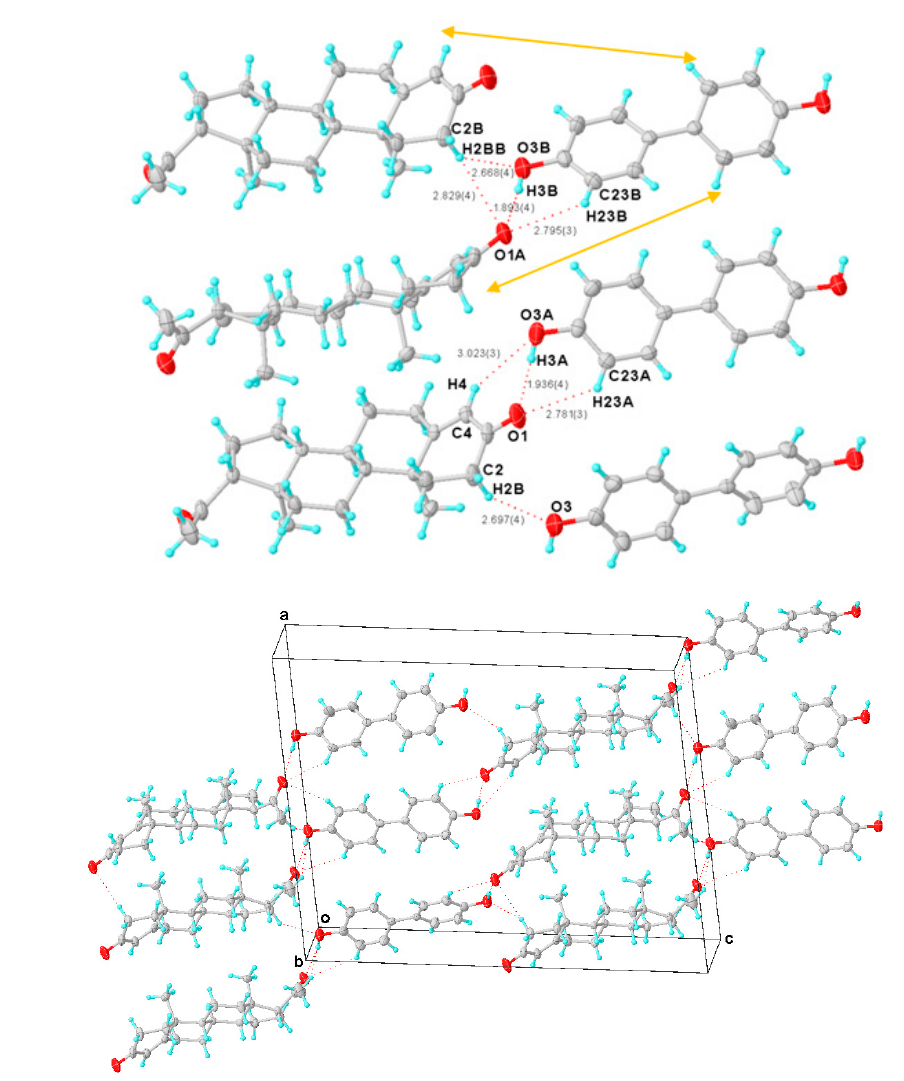
Figure 4. ( a ) Asymmetric unit of PROG-DOD. ( b ) Three-dimensional structure of PROG-DOD. The ellipsoids are drawn with 30% probability and all hydrogen bonds are represented with dotted lines.